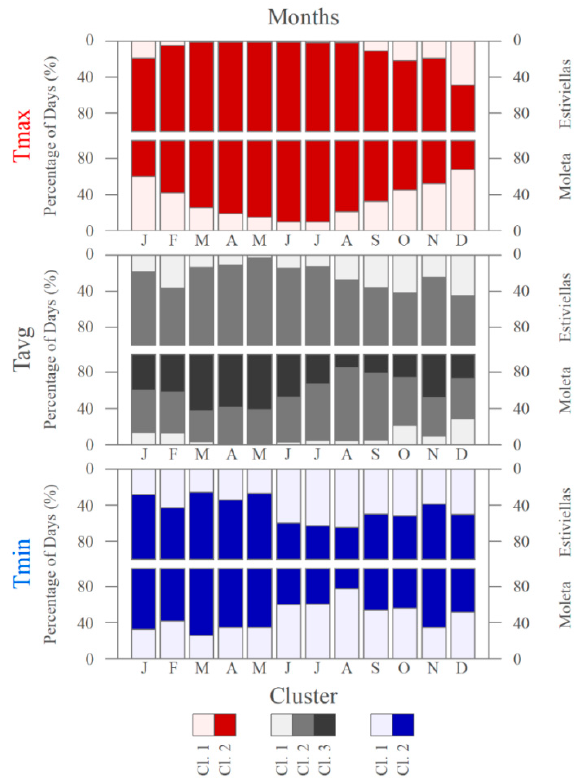
Figure 8. Tmax , Tmin and Tavg cluster monthly frequency (measured as daily percentage for the month).